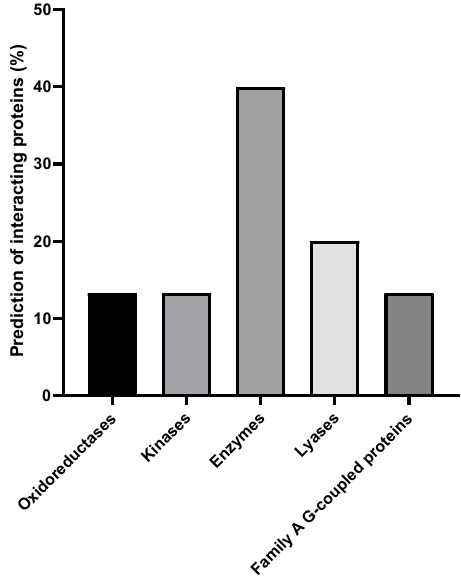
Figure 2. KTU-286 is predicted to interact with five different human protein classes. The in silico interactions were computed by using SwissTargetPrediction software, and the generated percentages of human proteins interacting with KTU-286 were used. Among identified interacting targets, 40% were proteins with unspecified enzymatic properties, 20% were various lyases, 13.3% were various kinases, 13.3% were various oxidoreductases, and 13.3% were various family A G-coupled proteins. KTU-286 showed predicted interactions with human arachidonate 5-lipoxygenase (ALOX5), prostaglandin E synthase (PTGES), and interleukin-8 receptor B (CXCR2). All major identified